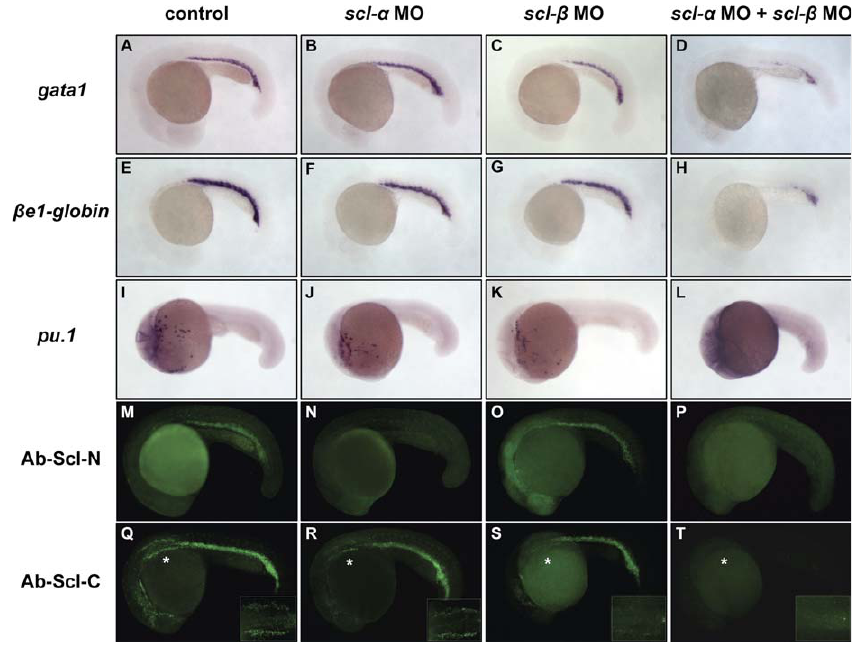
Figure 3. scl- a and - b Are Functionally Redundant in the Initiation of Primitive Hematopoiesis (A–L) WISH of gata1 (A–D), b e1-globin (E–H), and pu.1 (I–L). Similar expression of gata1, b e1-globin, and pu.1 were detected in 20-hpf control embryos (A, E, and I), scl- a morphants (B, F, and J), and scl- b morphants (C, G, and K). In contrast, expression of gata1, b e1-globin, and pu.1 were significantly reduced or absent in scl- a / b co-injected morphants (D, H, and L). All embryos are in lateral view with anterior to the left. (M–T) Immunohistochemistry staining of endogenous Scl proteins in 20-hpf control embryos (M and Q) and scl- a (N and R), scl- b (O and S), and scl- a / b co-injected (P and T) morphants using Ab-Scl-N (M–P) and Ab-Scl-C (Q–T). In scl- a morphants, the Ab-Scl-N (N), but not Ab-Scl-C (R), staining in the ICM was absent, showing that scl- a MO specifically blocks the translation of scl- a . In the scl- b morphants, the Ab-Scl-C staining was selectively abolished in the APLM, where only scl- b is transcribed ([S] asterisk, inset), demonstrating that scl- b MO specifically blocks the protein expression of scl- b . In the scl- a / b co-injected morphants, neither Ab-Scl-N nor Ab-Scl-C staining was detected (P and T). Insets in (Q–T) are dorsal views of the magnified APLM marked by asterisks. Embryos are in lateral view with anterior to the left. doi:10.1371/journal.pbio.0050132.g003 (data not shown). Examination of the expression of gata1 (Figure 3A, n ¼ 46/46; 3B, n ¼ 43/43; and 3C, n ¼ 41/41), b e1-globin (hbbe1) (Figure 3E, n ¼ 49/49; 3F, n ¼ 51/51; and 3G, n ¼ 49/49), and pu.1 (spi1) (Figure 3I, n ¼ 41/41; 3J, n ¼ 41/43; and 3K, n ¼ 45/45) by